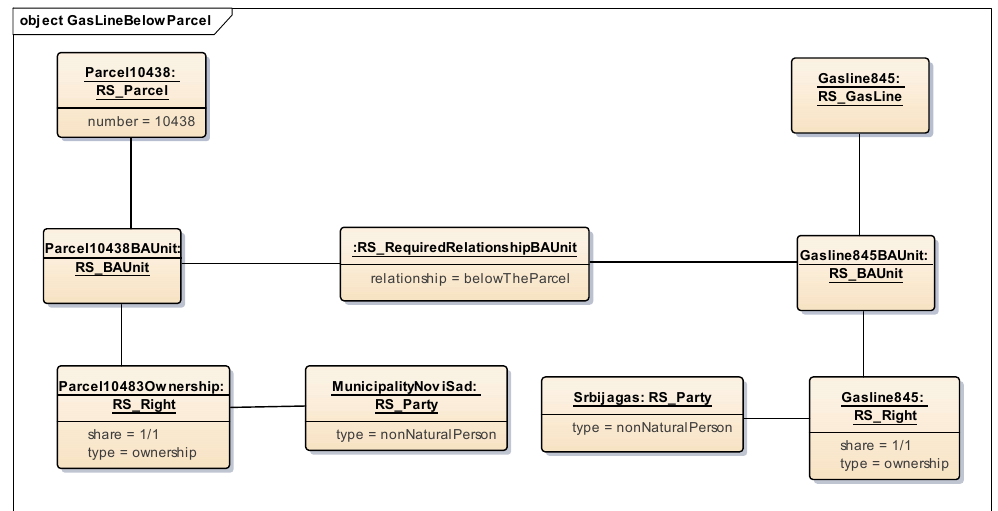
Figure 8. Instance diagram of a gas line located below the parcel.